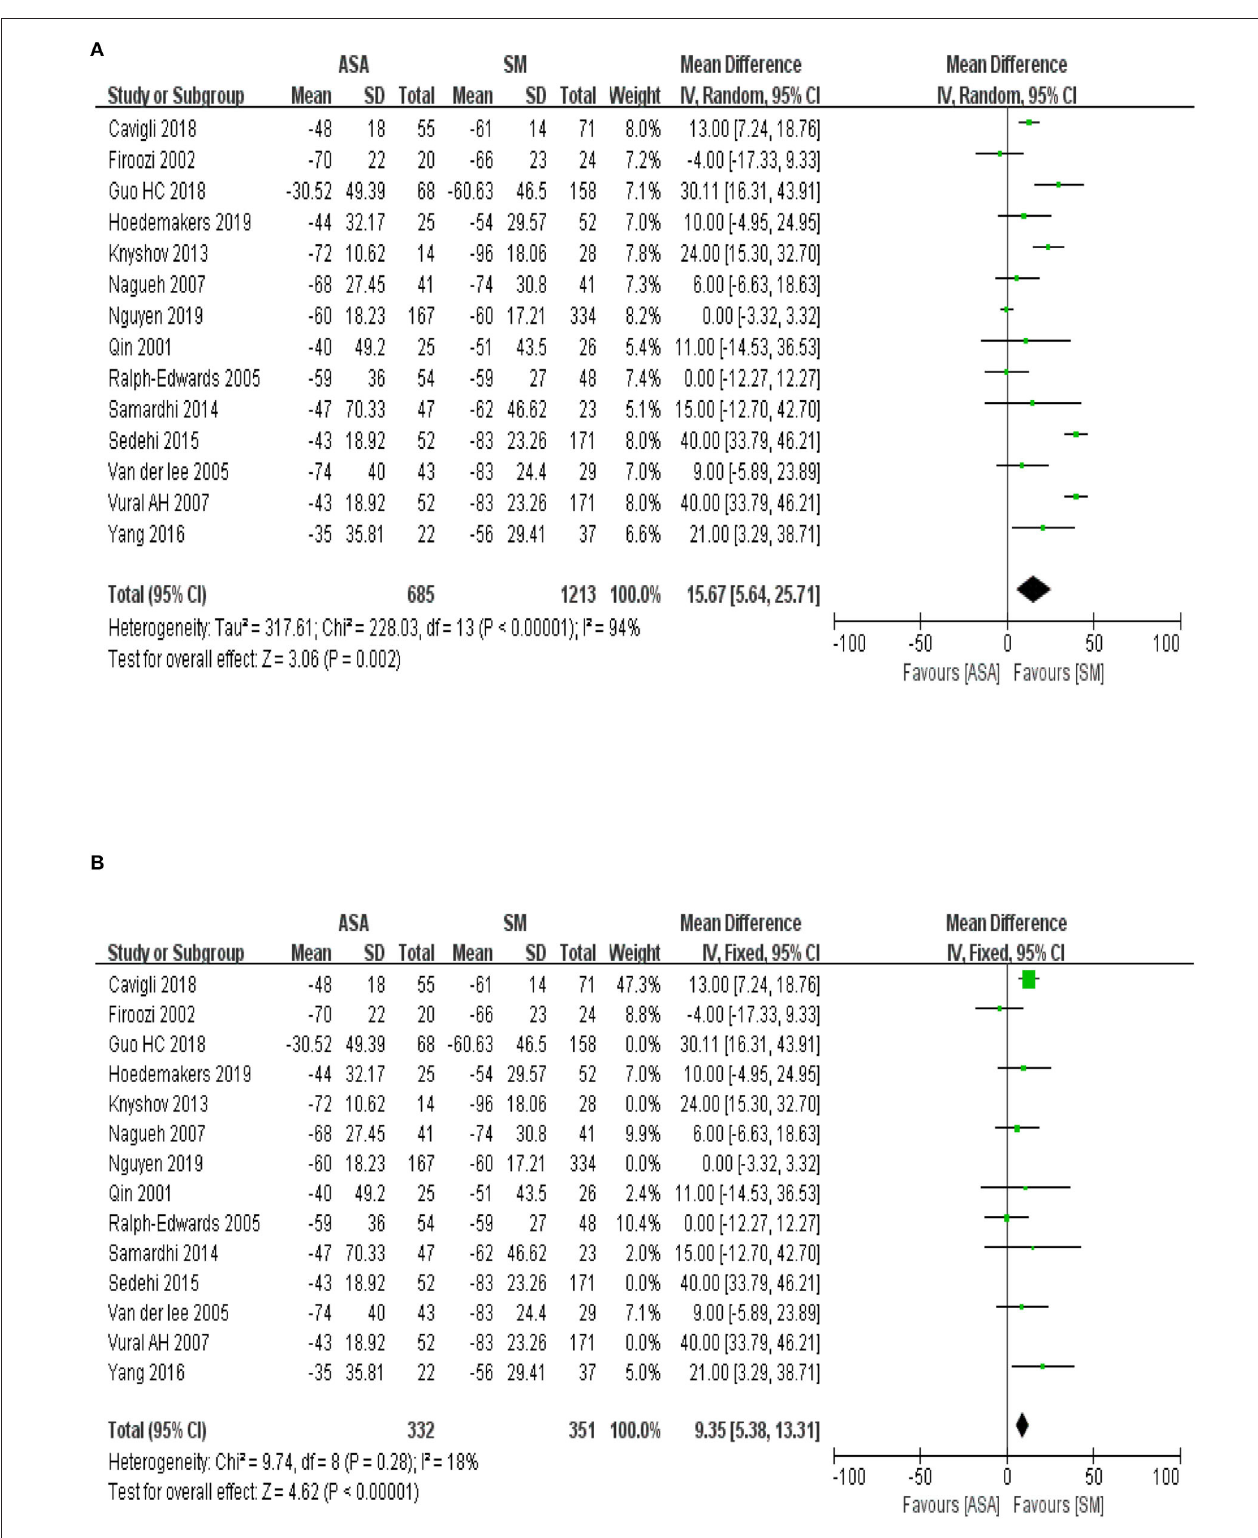
FIGURE 3 | (A) The forest map for the meta-analysis of the reduction in left ventricular outflow tract pressure gradient. IV, inverse variance; CI, confidence interval; Random, random effect mod. (B) The adjusted forest map for the meta-analysis of the reduction in left ventricular outflow tract pressure gradient. IV, inverse variance; CI, confidence interval; Fixed, fixed effect